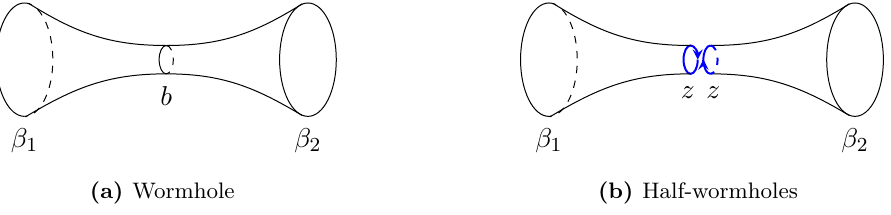
Figure 2. Contributions of a wormhole and b